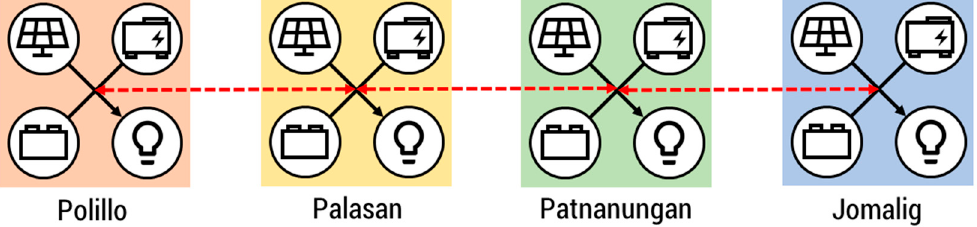
Figure 3. Architecture between the possible interconnections between the selected islands.